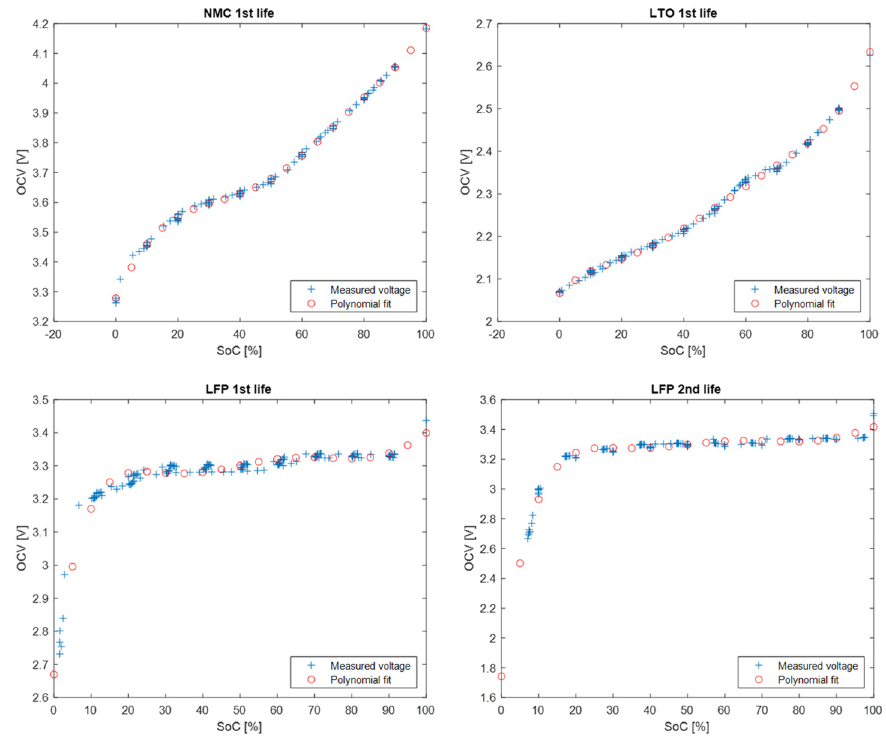
Table 2. Selected cell specifications to be used in the COF.